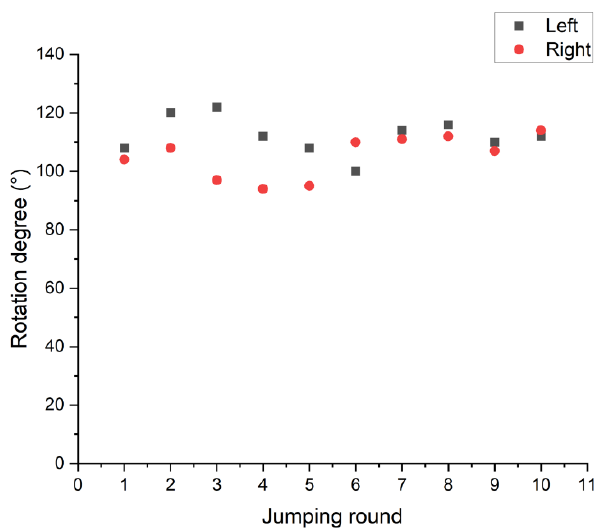
Figure 16. Rotation drive of the soft jumping robot.